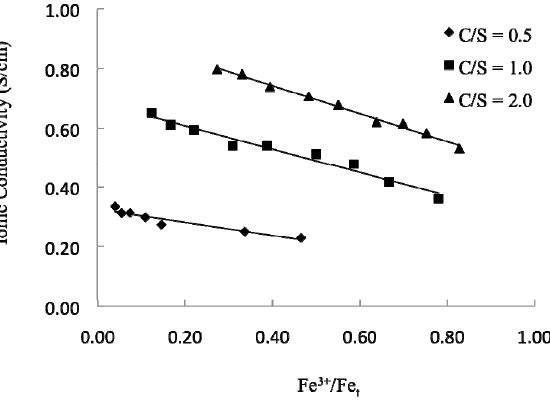
Figure 1. Variation of ionic conductivity at 1750K in the FeO-SiO 2 -CaO system with 30 mass% FeO, C/S= CaO / SiO 2 (data as reported in [12]).